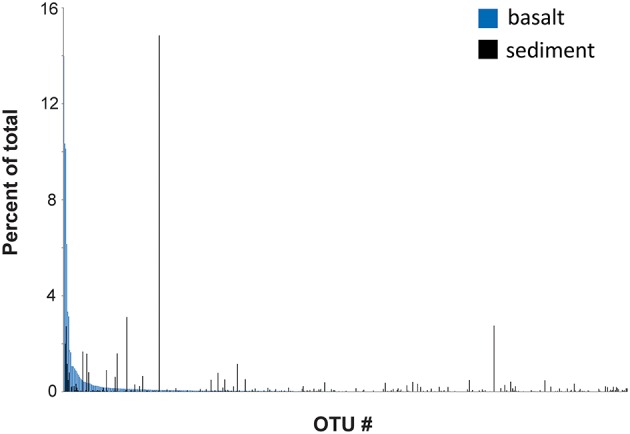
OTU rank abundance. Comparing the rank abundance of OTUs shared between the basalt-hosted community (Holes 1382A and 1383C) and the sediment-hosted (1383E). The abundance of each OTU across all basalt-hosted samples and across all sediment samples was compiled and the average abundance used (excluding the sedimentary breccia in Hole 1382A).